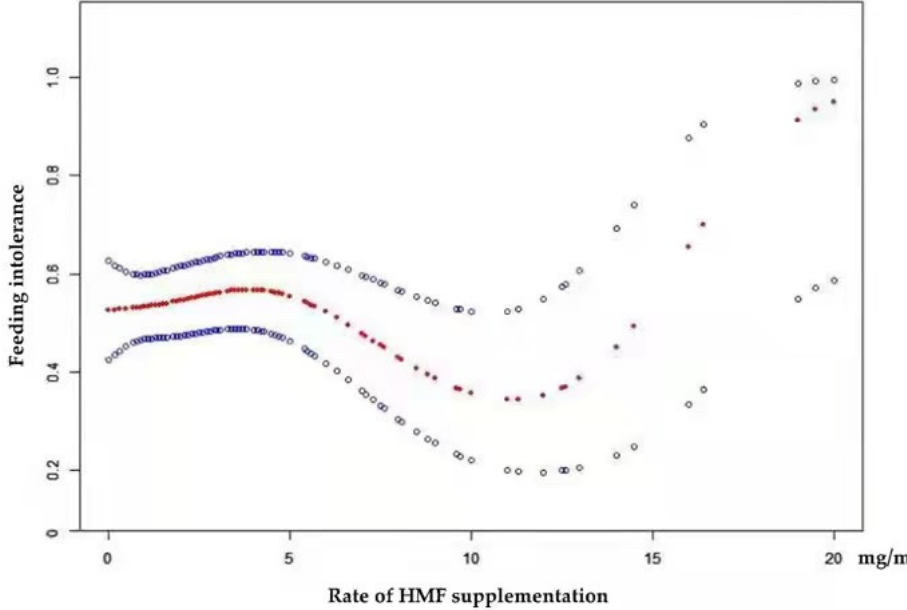
Figure 4. Estimated probability of experiencing feeding intolerance (FI) by rate of human milk fortifier (HMF) supplementation, based on a generalized additive model controlling for gestational age (GA); birth weight (BW); admission temperature; initial concentration of HMF. The red curve in the middle is the spline smoothing, and the blue curve on both sides represents the 95% confidence interval. Table 8. Threshold effect analysis of the relationship between rate of HMF supplementation and the risk of FI. Dates, 2015–2018.